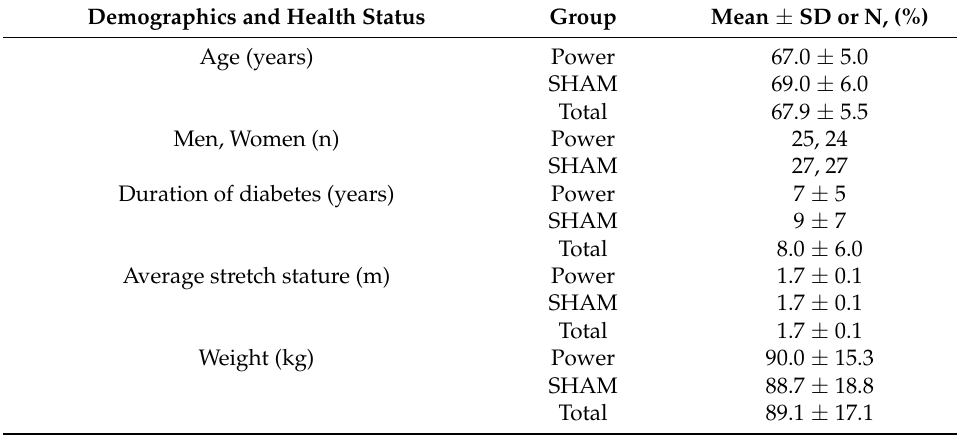
Figure 1. CONSORT 2010 Flow Diagram. Table 2. Baseline